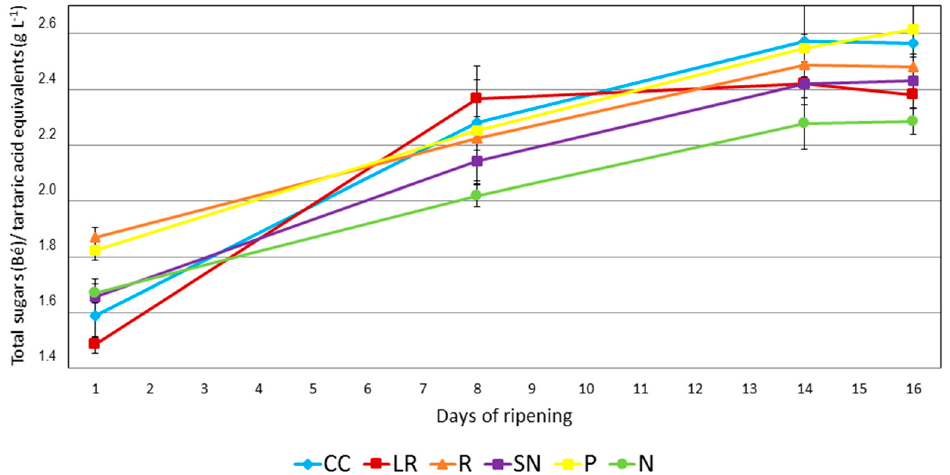
Figure 1. Evolution of the technological maturity (total sugars (Bé)/tartaric acid equivalents (g L − 1 )) during the ripening period for grapes from five different cultural practices and the reference (CC: Cover crops, LR: Leaf removal, R: Reference, SN: Sulfur and nitrogen addition to vine leaves, P: Specific pruning, N: Nitrogen addition to vine leaves).